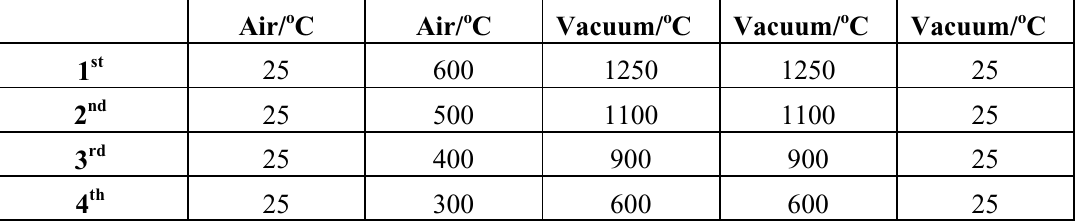
Table 2. Four different oven settings for sintering in